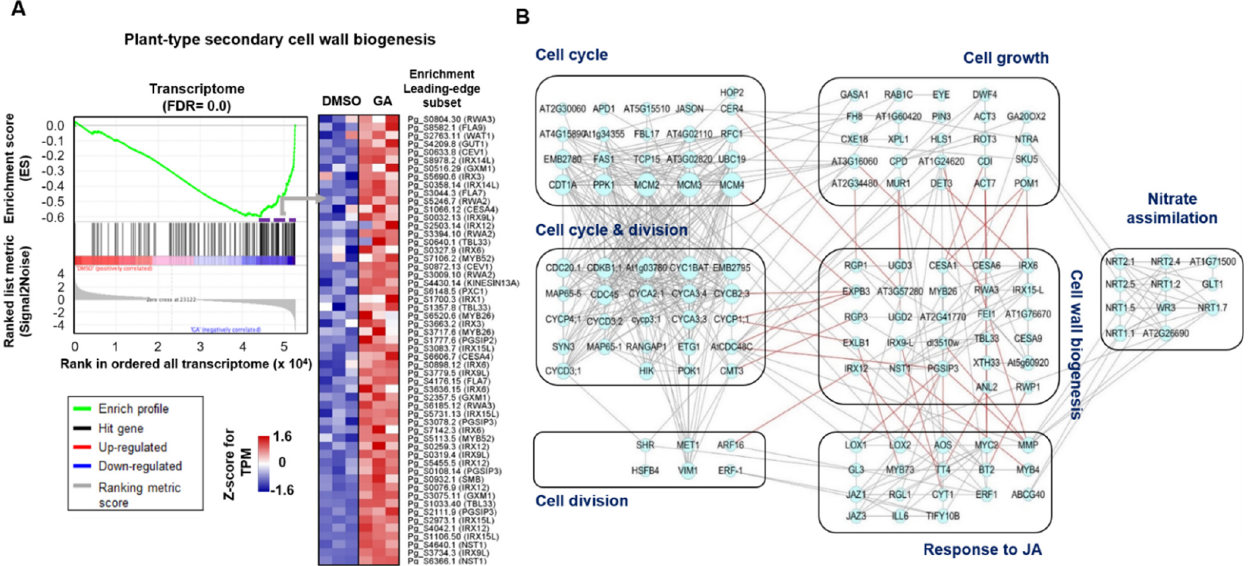
Figure 5. Functional enrichment of cell wall biogenesis in P. ginseng root in response to GA and the function-related transcriptional network. ( A ) Enrichment plot for the plant-type secondary cell wall biogenesis (GO: 0009834), and an expression heatmap of 55 genes related to this pathway (FDR = 0.0). ( B ) Transcriptional network of up-regulated genes related to cell wall biogenesis (57 genes), cell cycle and division (120 genes), cell growth (54 genes), response to JA (42 genes), and nitrate assimilation (13 genes). In the network, red lines indicate the connection of genes between cell wall biogenesis and other functional categories.